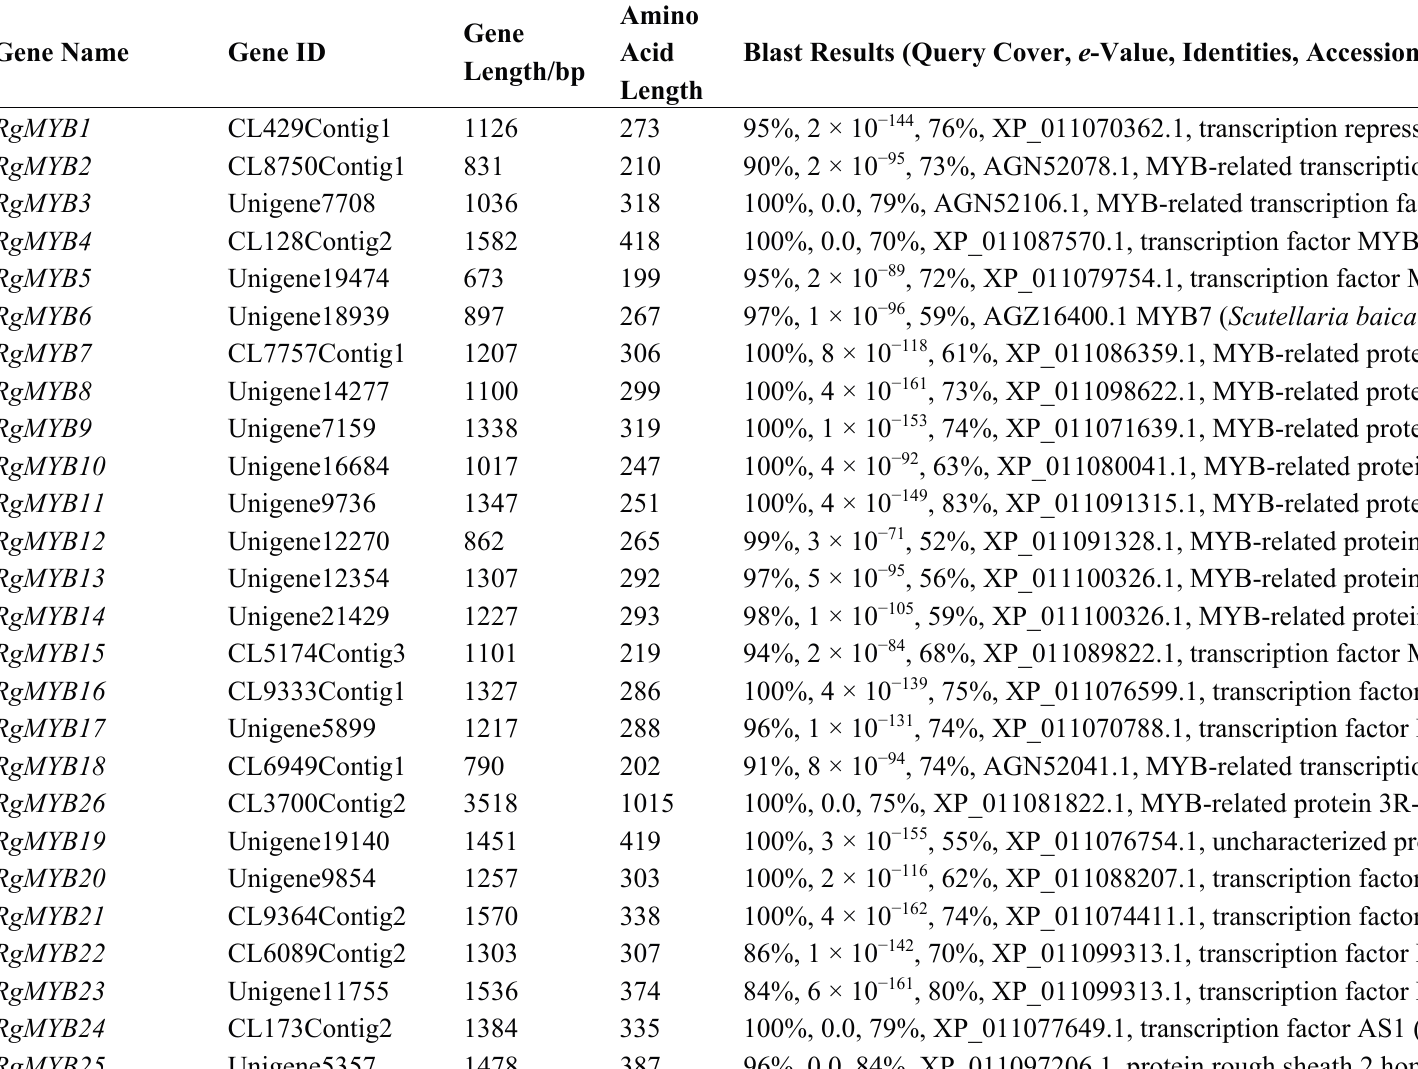
Table 1. MYB genes identified in Rehmannia glutinosa